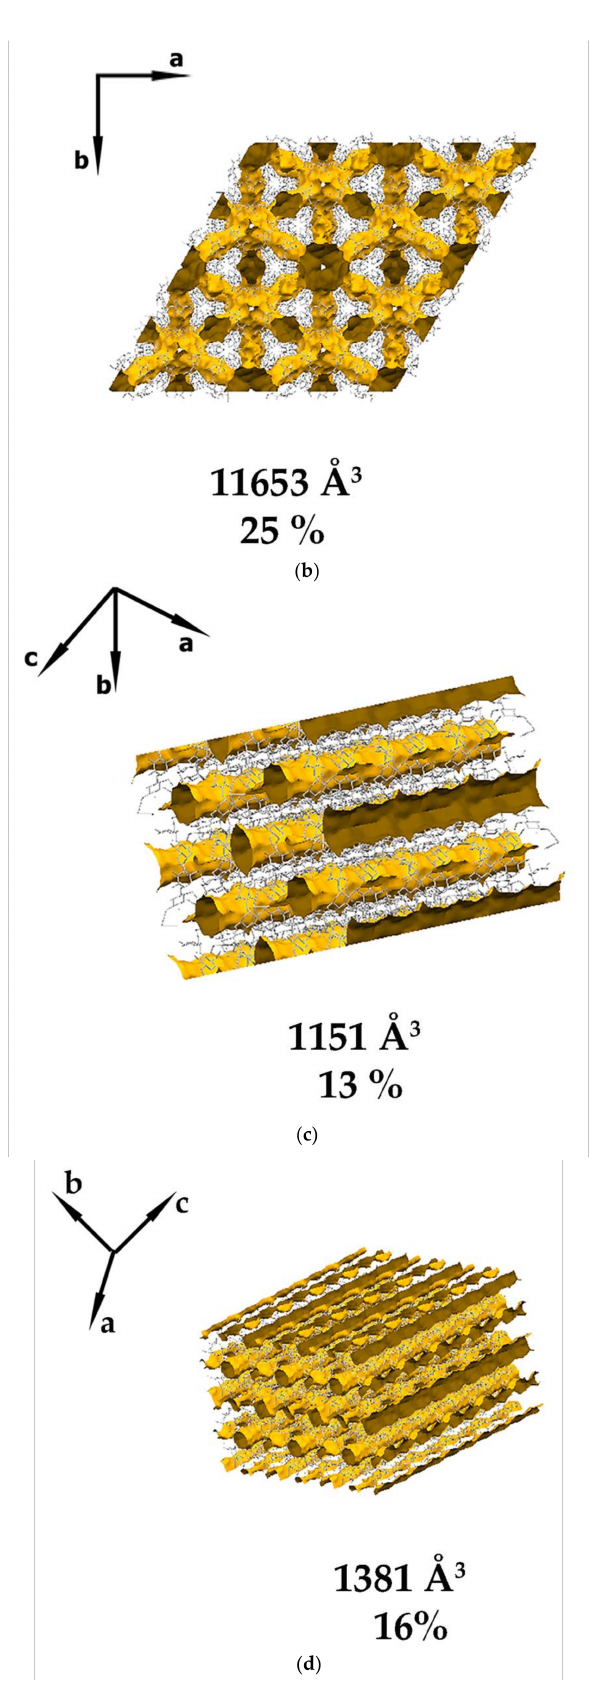
Figure 6. Solvent-accessible surface of ( a ) α -, ( b ) β -, ( c ) ε -, and ( d ) δ -phase, calculated in mercury (probe radius, 1.2 Å; approximate grid spacing, 0.7